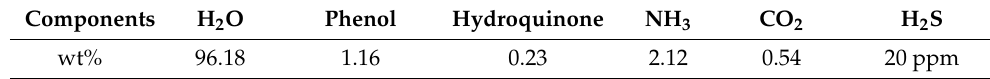
Table 1. Wastewater feed composition.